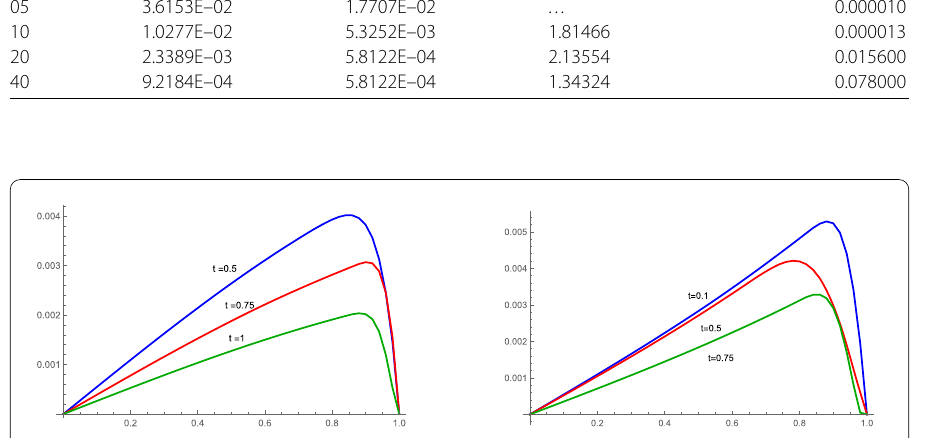
Table 11 The L ∞ -norm and L 2 -norm with h = 2 τ = 1